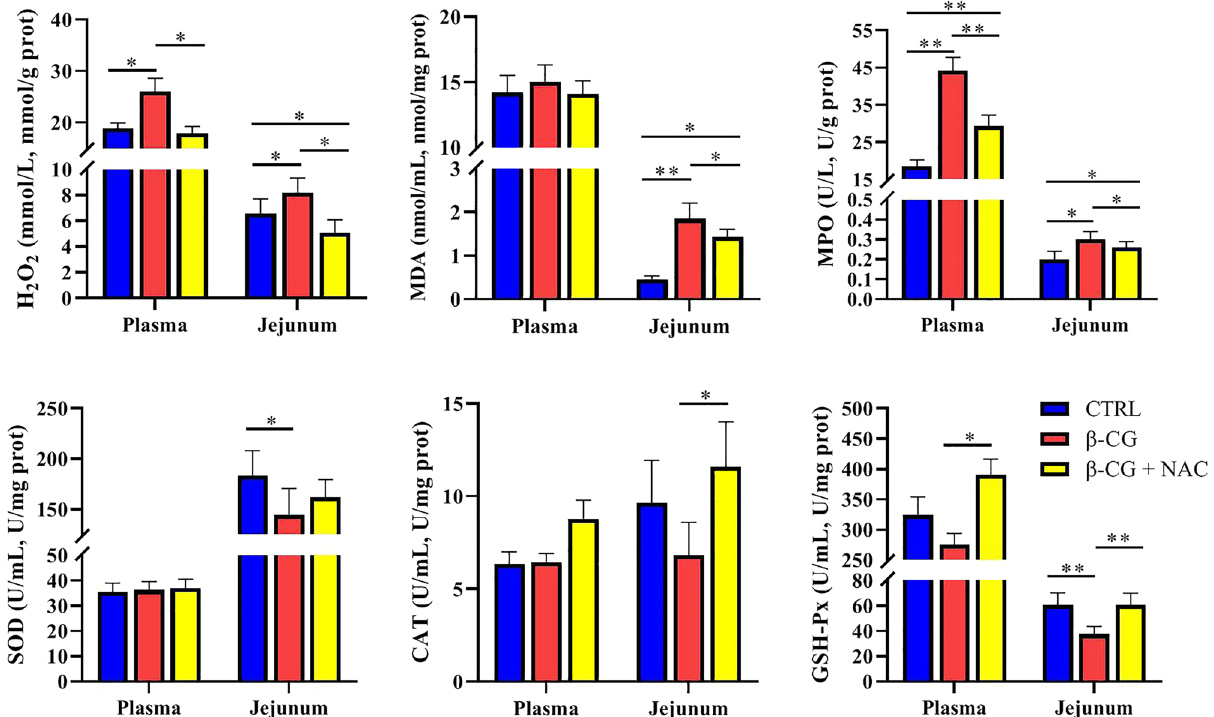
Figure 3. Oxidants and antioxidant proteins in the plasma and jejunal mucosa of piglets. Activities of superoxide dismutase (SOD), catalase (CAT), and glutathione peroxidase (GSH-Px), as well as the concentrations of H 2 O 2 , MDA, and MPO in the plasma and jejunal mucosa were determined by using commercially available kits. Data are means ± SEM, n = 8. * P < 0.05, ** P <